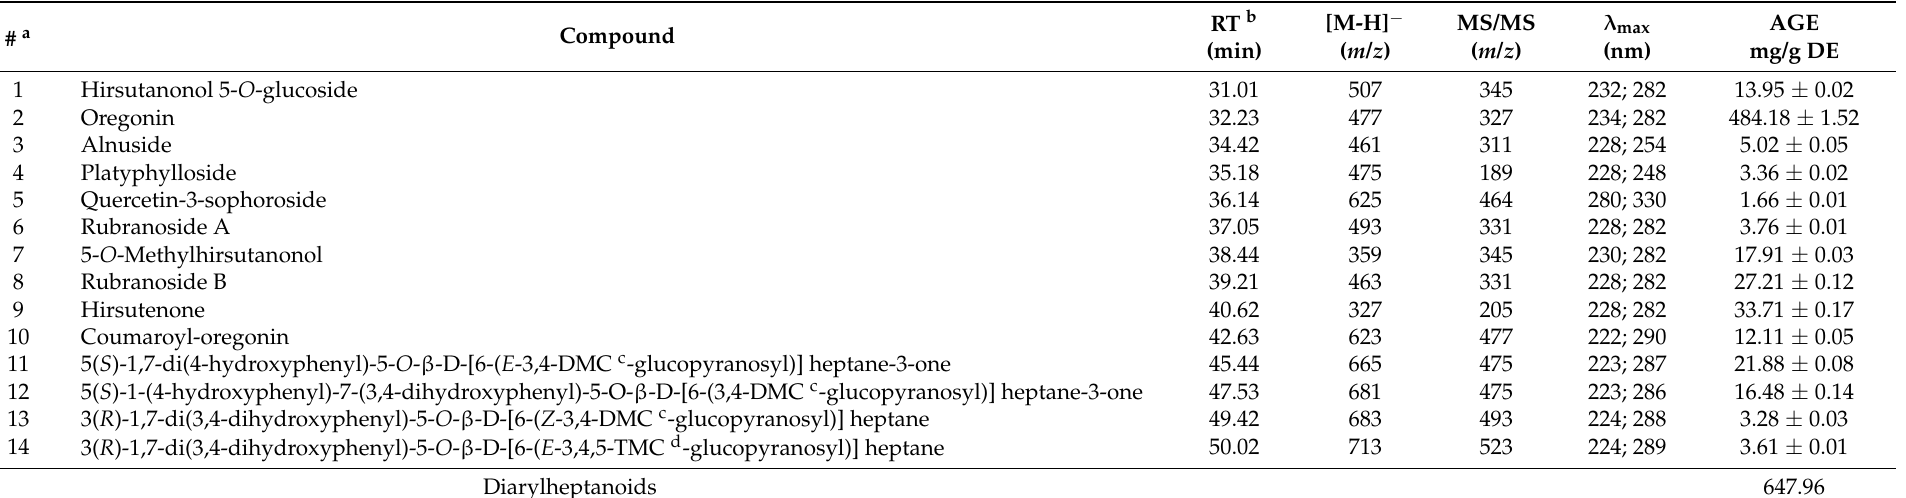
Table 1. Qualitative and quantitative analysis of A. glutinosa stem bark extract (AGE) by LC-DAD-ESI-MS/MS analysis. Results, which are the mean ± standard deviation (S.D.) of three independent experiments in triplicate ( n = 3), were expressed as mg of oregonin equivalents (OE)/g of dry extract (DE) for diarylheptanoids, and as mg of quercetin-3- O -glucoside equivalents (QGE)/g of DE for quercetin